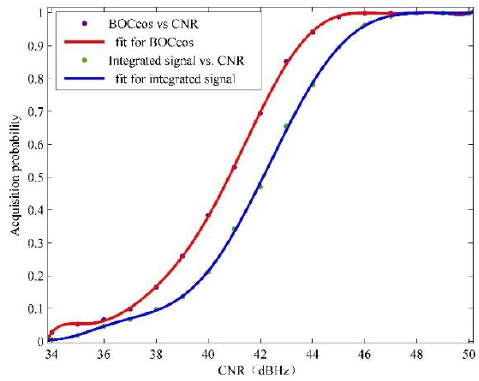
Figure 5. The acquisition probabilities of an integrated signal and a BOC signal.